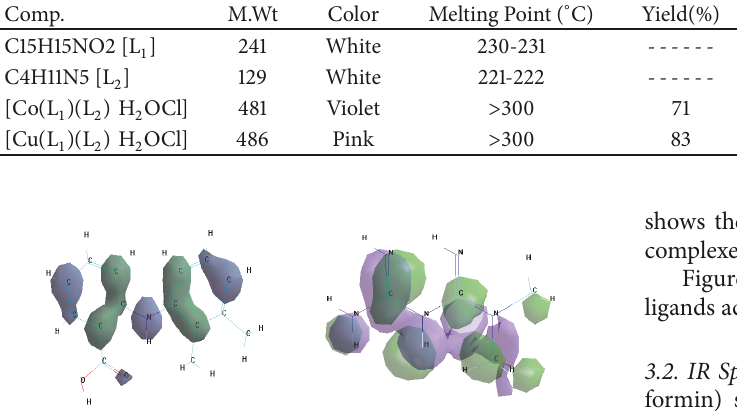
Figure 1: HOMO-LUMO categories of the ligands (mefenamic acid and